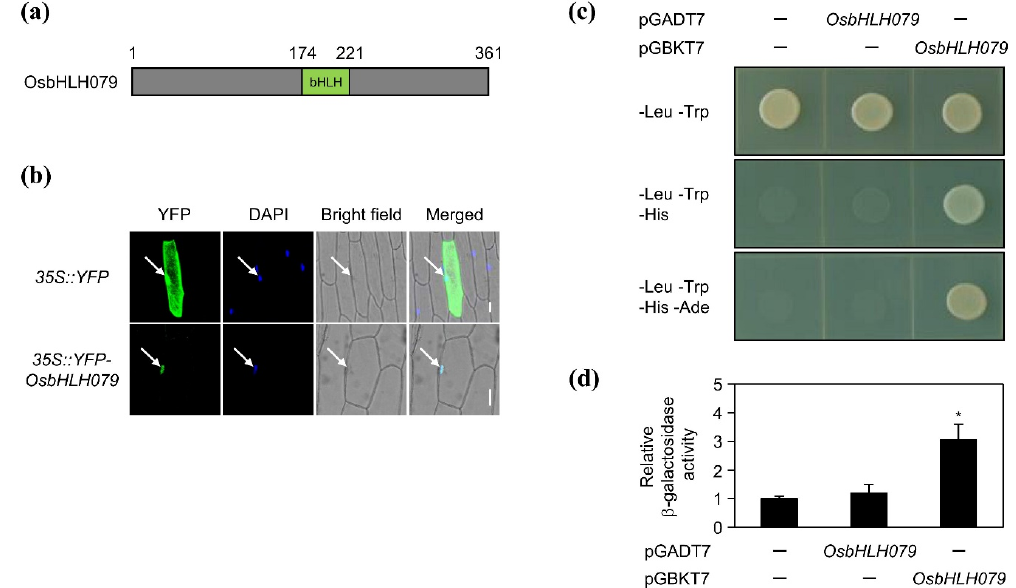
Figure 4. OsbHLH079 as a putative transcription factor. ( a ) Domain analysis of the 361-amino-acid-long OsbHLH079 protein. The green box indicates a basic helix–loop–helix domain. ( b ) Subcellular localization of OsbHLH079 in onion epidermal cells. The 35S::YFP and 35S::YFP-OsbHLH079